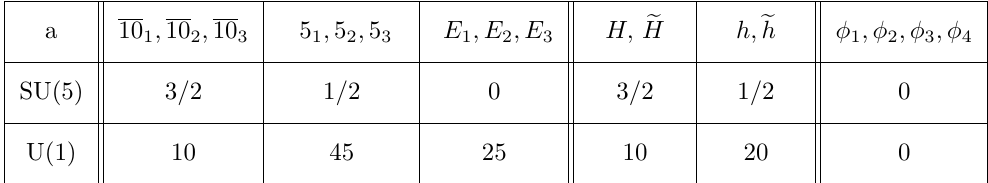
Table 3 . Values of T a K (where K = SU(5) , U(1) ) for the chiral matter superfields of the flipped SU(5)